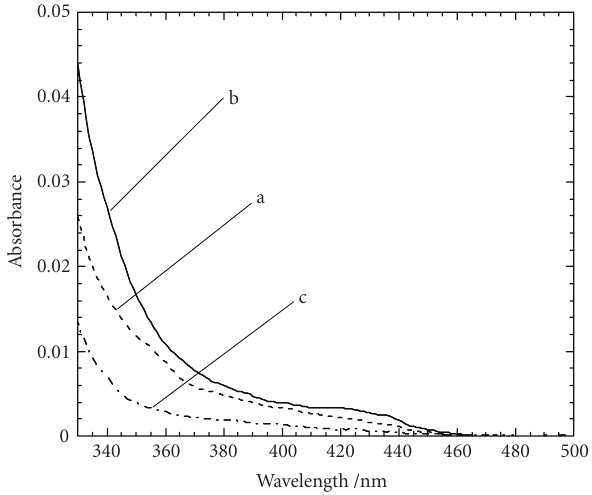
Figure 5: Absorption spectra of silica particles with and without ZnSe-based NCs in solution: (a) NC-incorporating silica particles prepared using Solution 1, (b) NC-incorporating silica particles prepared using Solution 2, and (c) silica particles without incorpo- rating the NCs prepared using Solution 1.